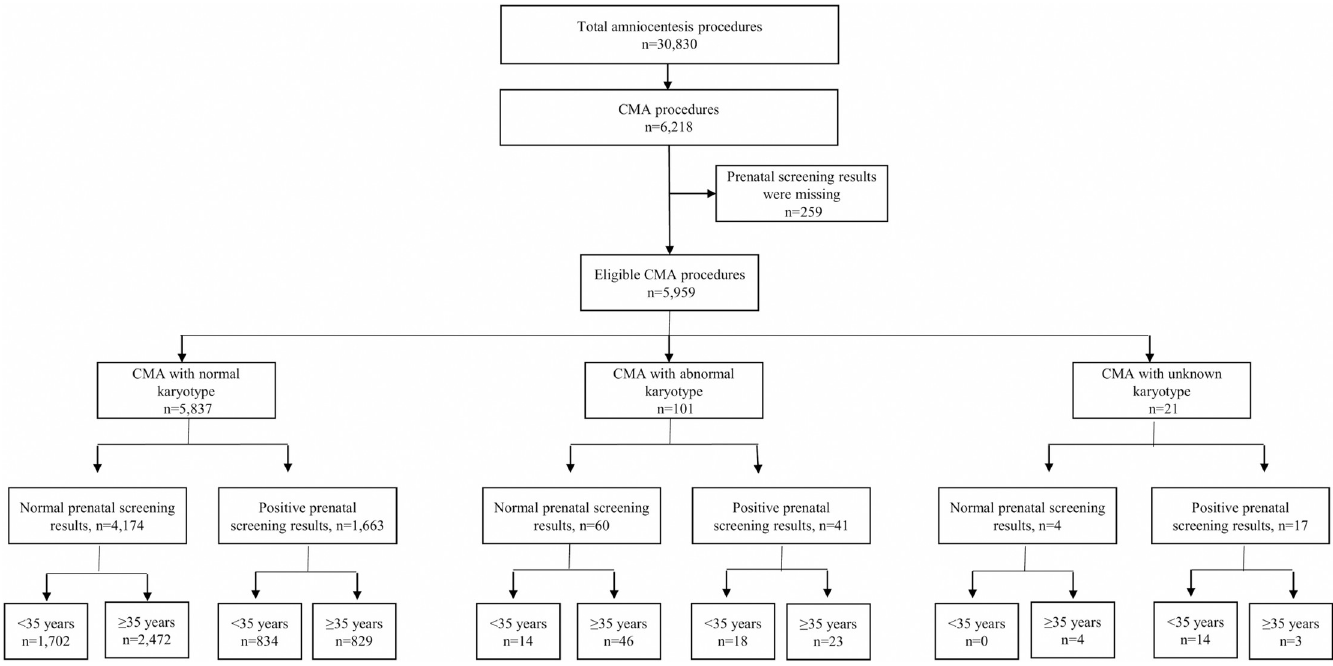
Fig 1. Study flow chart. Fig 1 showing the number of pregnancies analysed in each subgroup.